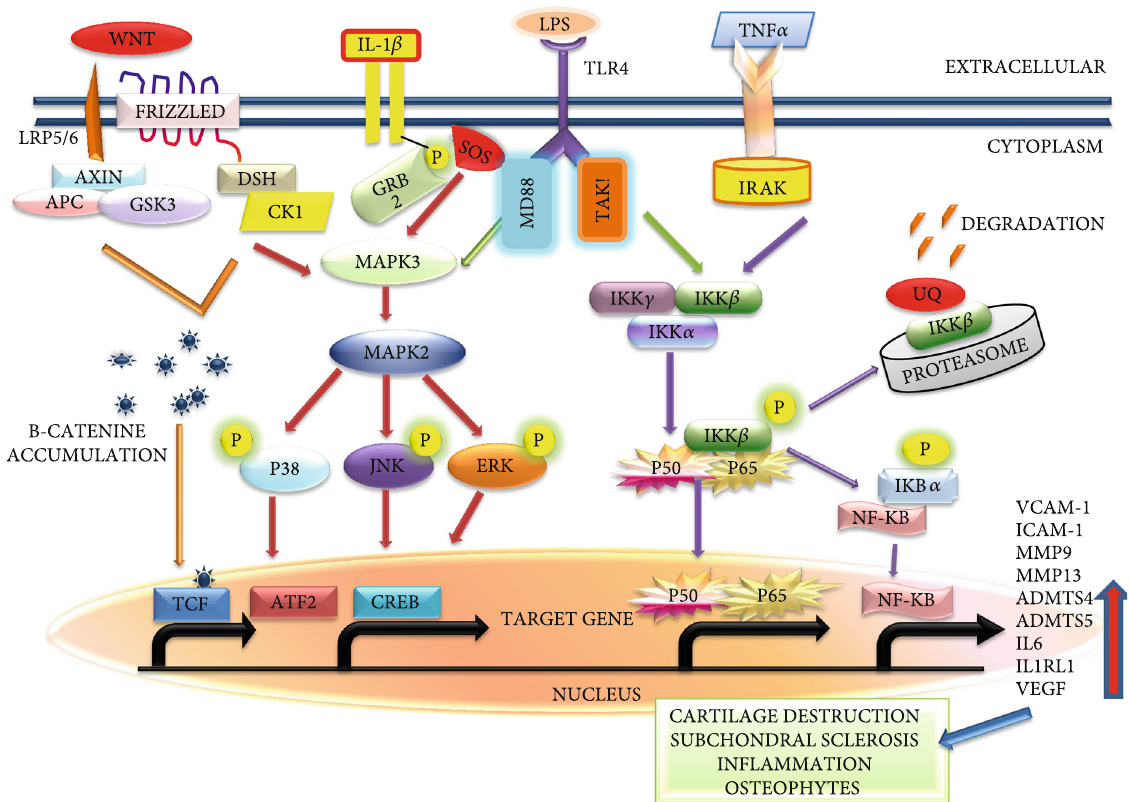
Figure 3: Biomarkers play role in pathology of OA by multiple signaling pathways including NF- κ B pathway, MAPK pathway, Wnt-signaling pathway, and TLR pathway. Wnt: wingless and Int-1; APC: adenomatous polyposis coli; GSK3 β : glycogen synthese kinase; DSH: phosphoprotein disheveled; IL-1 β : interleukin 1 beta; GRB2: growth factor receptor-bound protein 2; MAPK: mitogen-activated protein kinase; ERK: extracellular signal-regulated kinase; JNK: c-Jun N-terminal kinase; TLR4: toll-like receptor 4; MD88: myeloid di ff erentiation primary response 88; IKK: inhibitor of nuclear factor- κ B (I κ B) kinase; NF- κ B: nuclear factor kappa light chain enhancer of activated B cells; IRAK: IL-1 receptor-associated kinase; P: phosphorylation; UQ: ubiquitin; CREB: cAMP-responsive element binding protein; TCF: T cell factor; TAK1: transforming growth factor b-activated kinase 1; MMP: matrix metallopeptidases; VCAM-1: vascular cell adhesion protein; ICAM-1: intercellular adhesion molecule